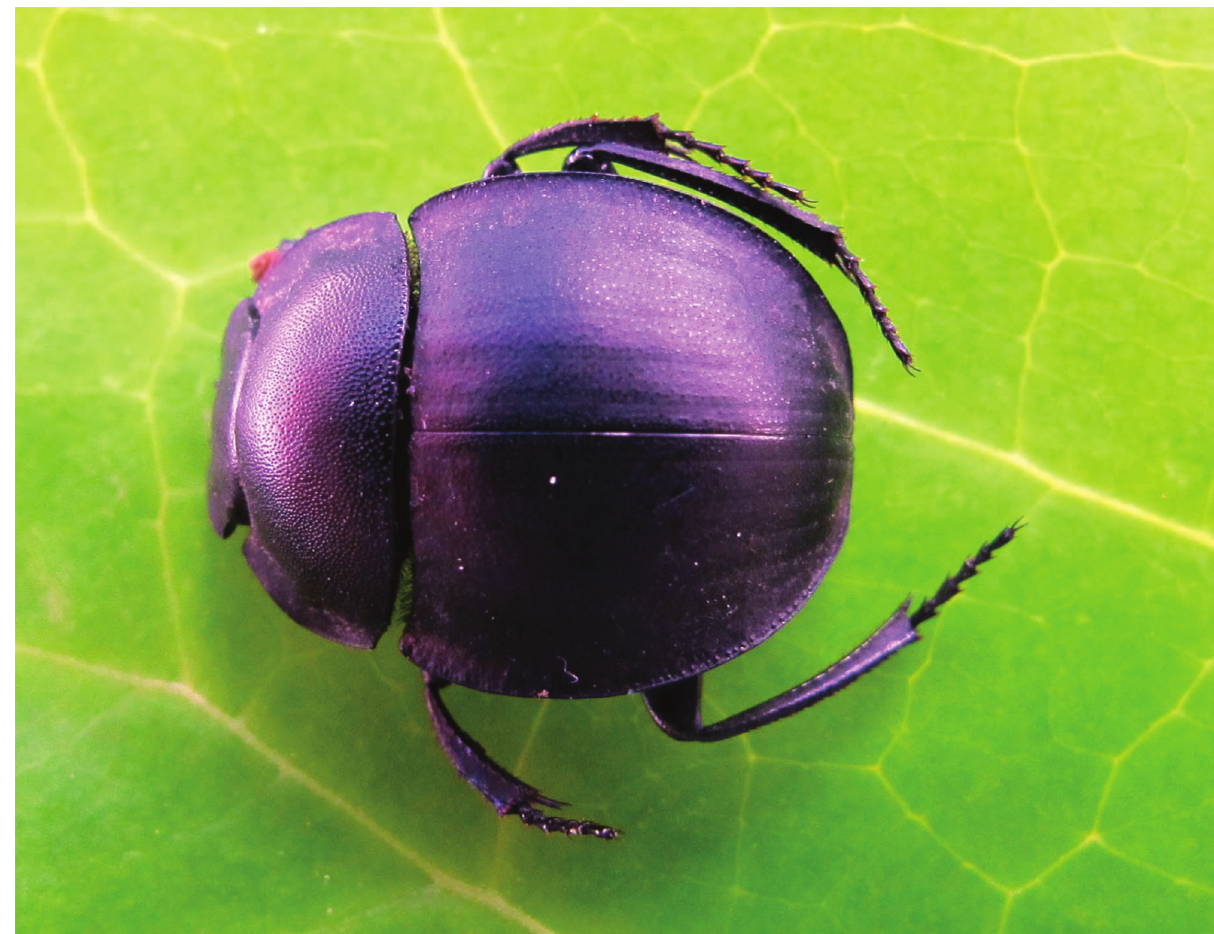
Figure 1: One of the rediscovered Gyronotus glabrosus individuals (Scarabaeidae). This genus belongs to the Canthonini tribe, which is considered to be of substantial biodiversity and conservation value.